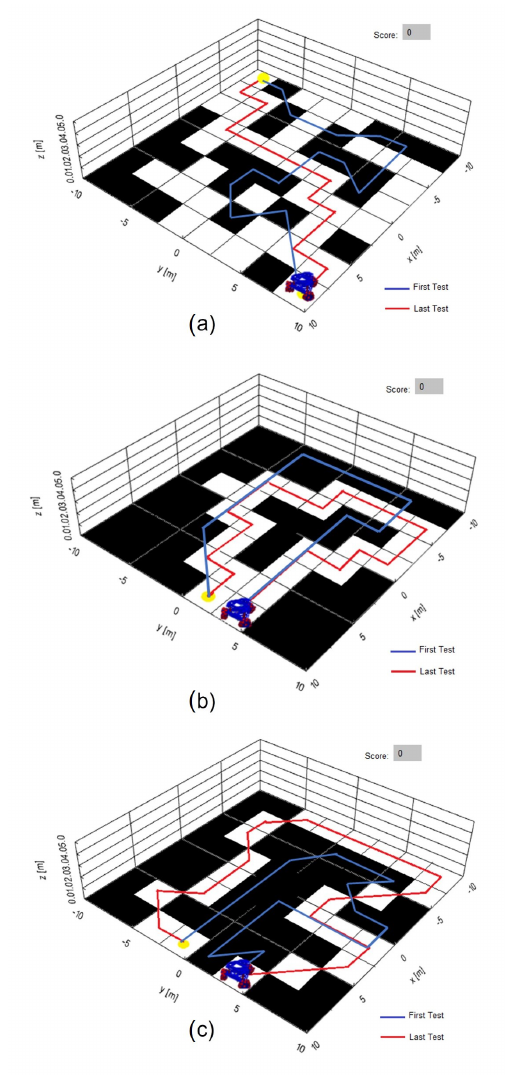
Figure 25. Trajectory for training boards programmed; a blue line indicates the first test carried out and a red line is the trajectory after 30 repetitions to reach zero penalties.( a ) Test Board 1 with linear movements of the eyeball and the omnidirectional robot. ( b ) Test Board 2 with linear movements of the eyeball and the omnidirectional robot. ( c ) Test Board 3 with linear and combinational movements of the eyeball and diagonal trajectories of the omnidirectional robot.